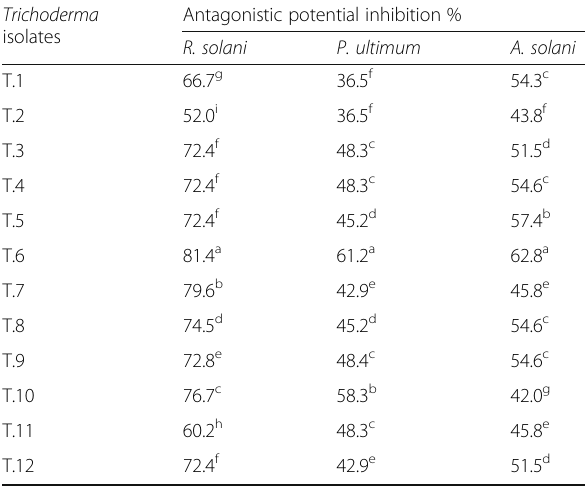
Table 3 Antagonistic potential of Trichoderma isolates against Rhizoctonia solani , Pythium ultimum , and Alternaria solani Trichoderma isolates